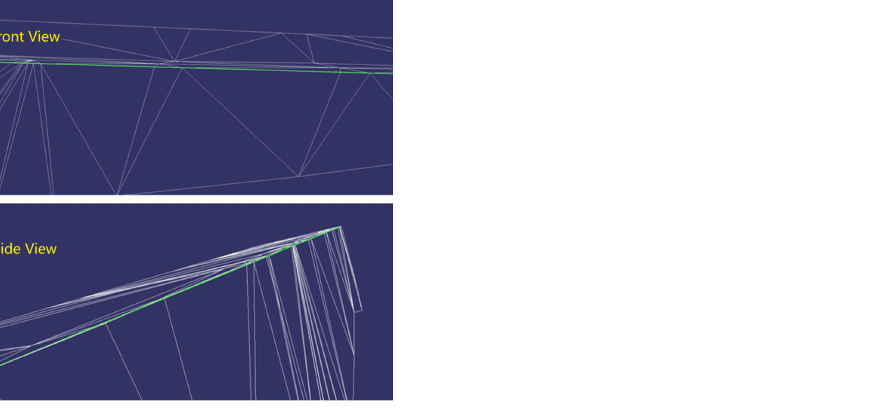
Figure 10. Rendering of local triangulation after edge line restoration. Green line is the edge line of the building model, and the white lines are TINs of the building model.